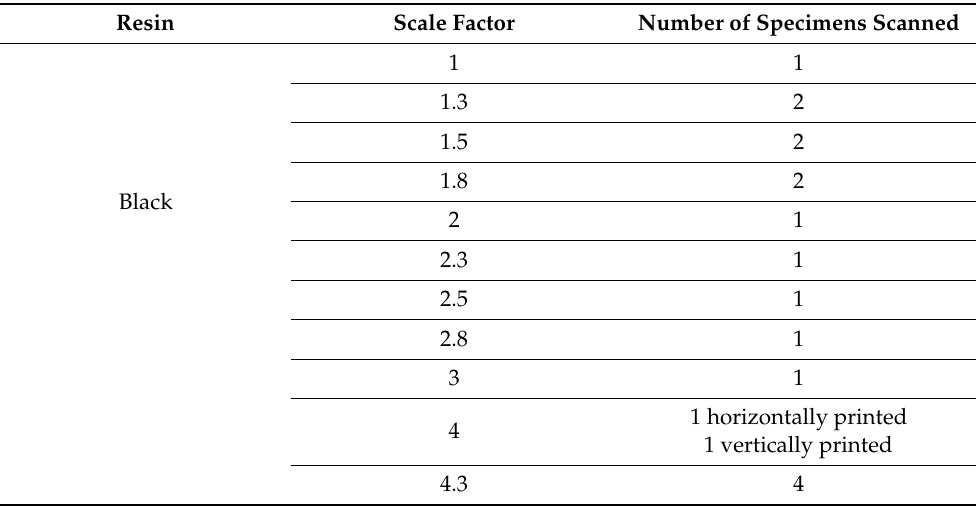
Table 4. List of samples analysed by micro-CT. The samples were printed vertically, unless other- wise